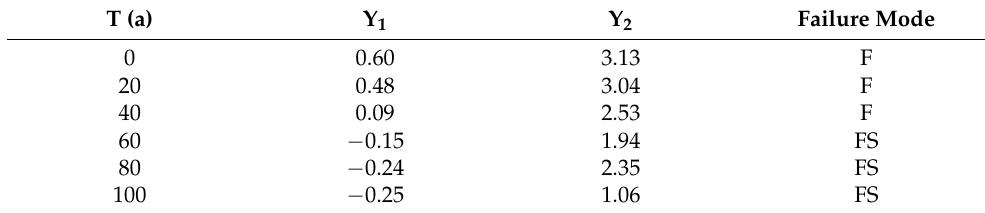
Table 6. Failure modes of bridge piers over 100 years of service.